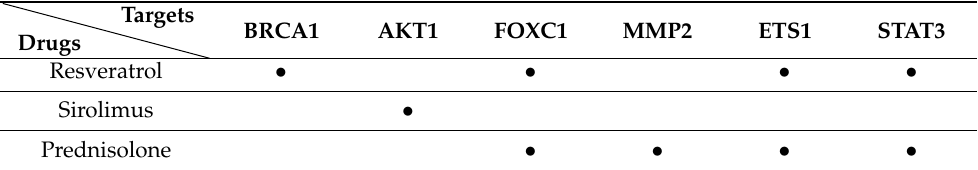
Table 4. Potential multi-molecule drugs and their corresponding target genes for TNBC. • : The targets of the potential multi-molecule drugs.